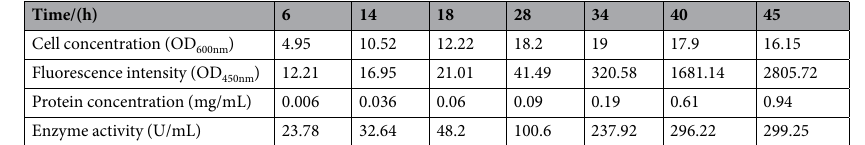
Table 2. sfGFP-ARG1 fusion protein in fed-batch